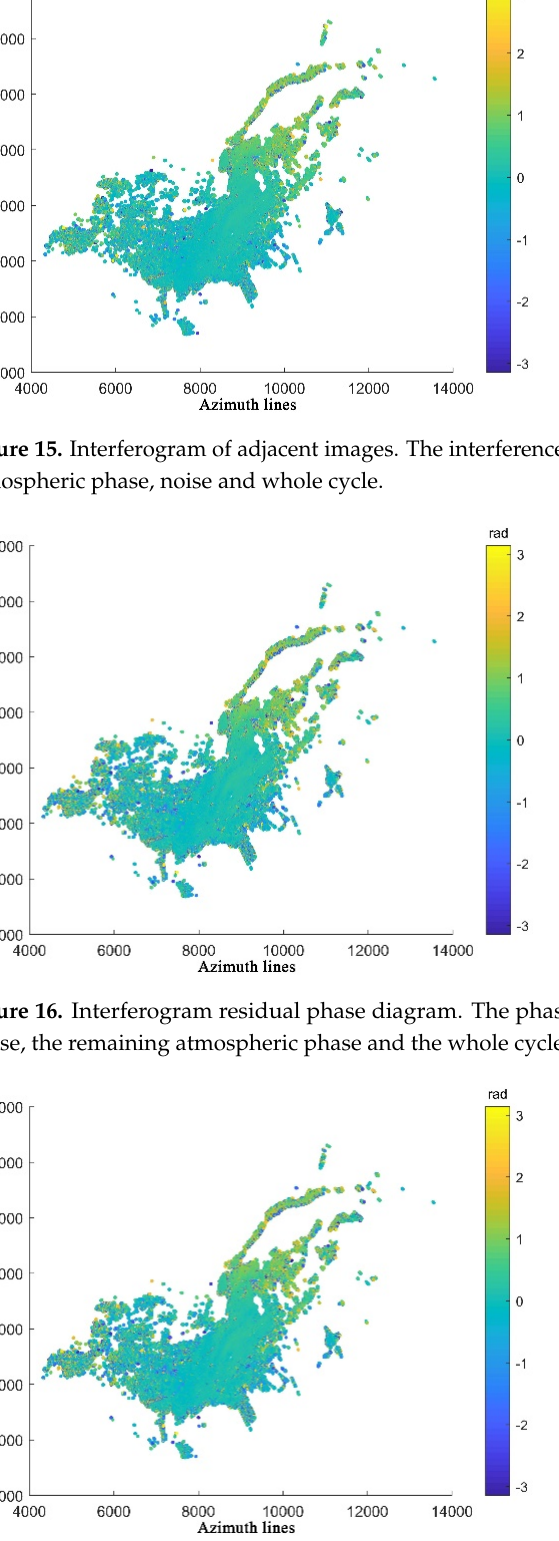
Fig 18 . Residual phase diagram after unwrapping. The interference phase contains only a small amount of deformation phase and atmospheric phase, so it is easier to untangle and reduce the unwinding error.